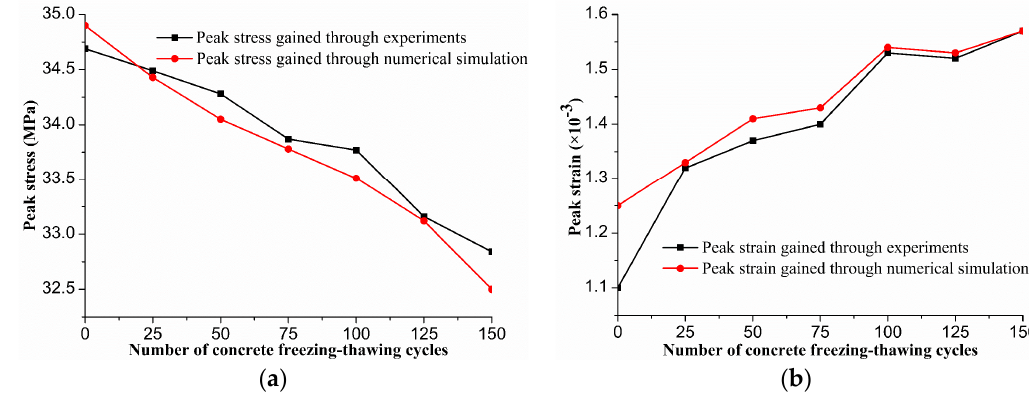
Figure 5. ( a ) Peak stress and ( b ) peak strain of concrete under different numbers of freezing–thawing cycles. ( a ) Peak stress and ( b ) peak strain of concrete under di ff erent numbers of freezing–thawing cycles.